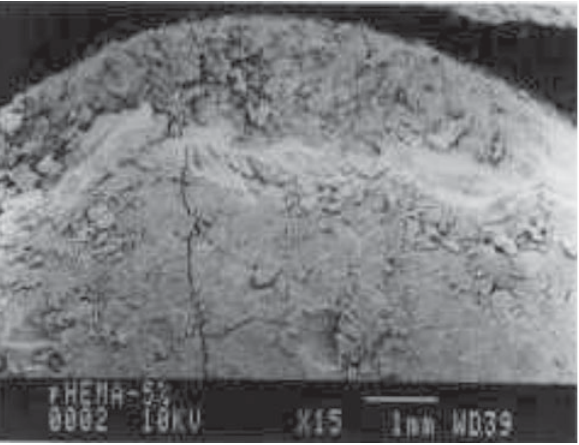
Figure 1. SEM micrograph of UHMWPE substrate with pHEMA